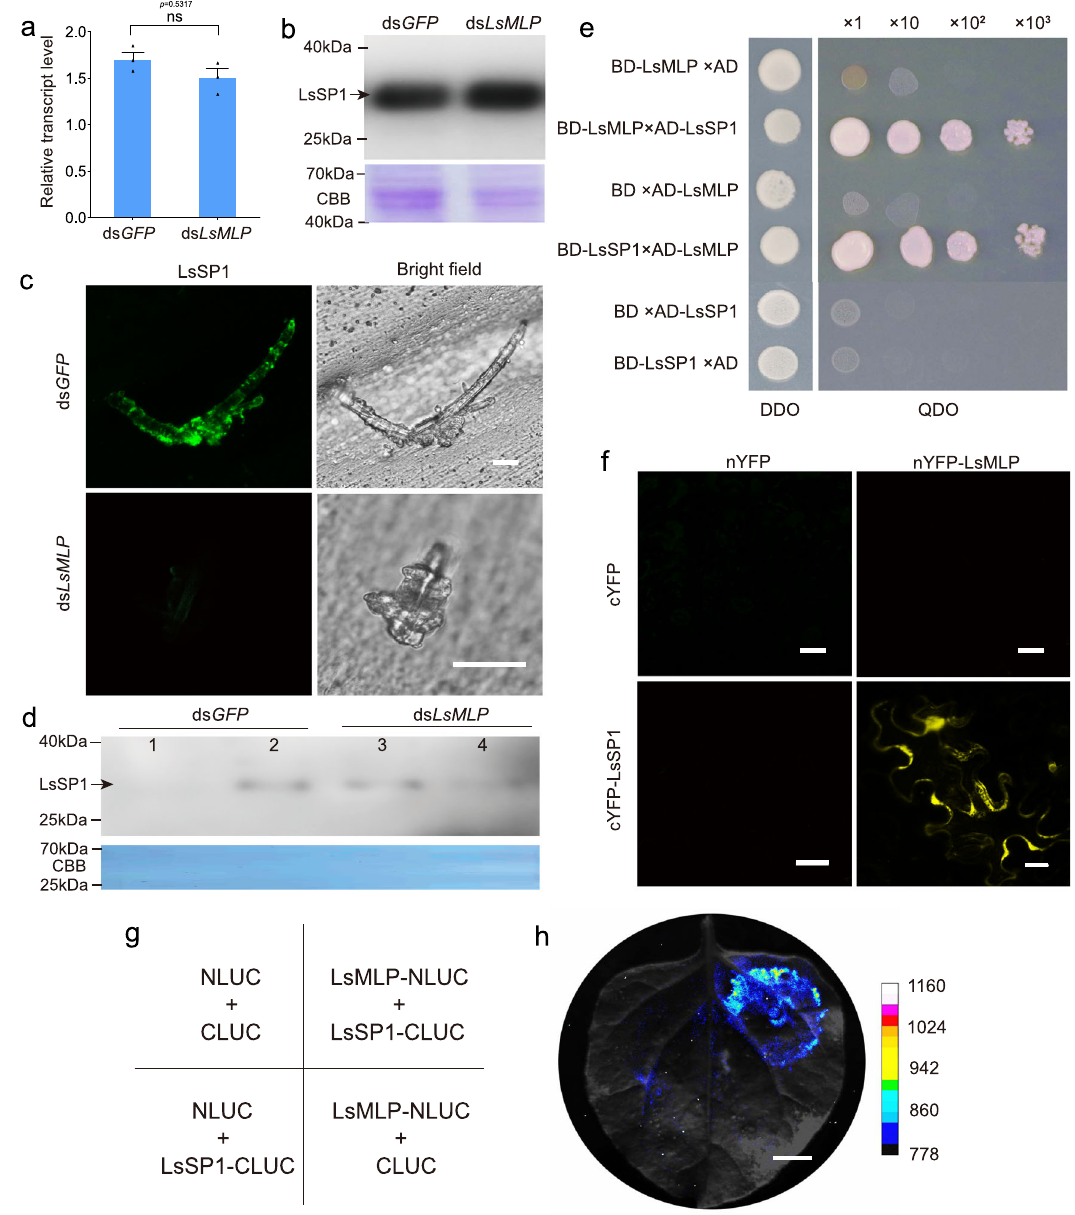
Fig.3|LsSP1bindstoasalivarysheathproteinLsMLP.a , b In fl uenceofds LsMLP treatment on the LsSP1 abundance in salivary gland quanti fi edby qRT-PCR ( a ) and western-blotting ( b ) assays. Data are presented as mean values ±SEM ( n =3 inde- pendent biological replicates). P -values were determined by two-tailed unpaired Student ’ s t test.ns,notsigni fi cant. c LsSP1stainingofsalivarysheathsecretedfrom dsRNA-treated Laodelphaxstriatellus .Thesalivarysheathssecretedfromds GFP -or ds LsMLP -treated L. striatellus were probed with the anti-LsSP1 serum conjugated withAlexaFluor ™ 488NHSEster(green),andexaminedbyLeicaSP8.Bars=20 μ m. d Detection of LsSP1 in watery (lane1, lane3) and gel saliva (lane 2, lane 4) secreted fromds GFP -ords LsMLP -treated L.striatellus . e Yeasttwohybridassaysshowingthe